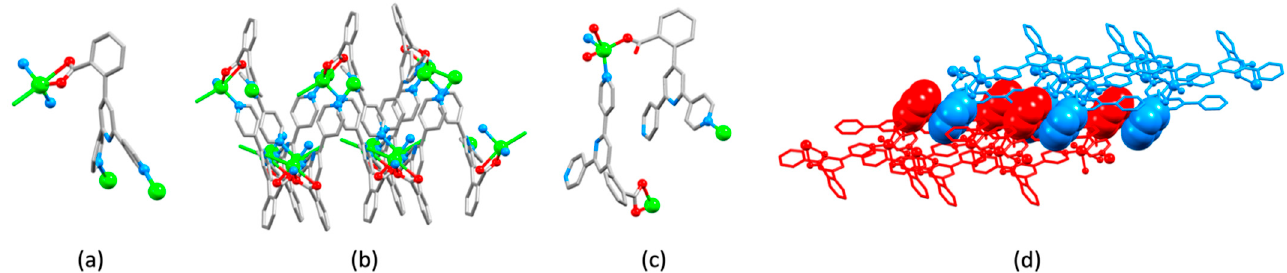
Figure 23. ( a ) The tritopic binding-mode of 34 – in [Zn( 34 )Cl] n (CSD refcode FIZVUH) and ( b ) part of a 2D-sheet in Figure 23. (a) The tritopic binding ‐ mode of 34 – in [Zn( 34 )Cl] n (CSD refcode FIZVUH) and (b) part of a 2D ‐ sheet in [Zn( 34 )Cl] n . ( c ) The two crystallographically independent 34 – linkers in [Zn 2 ( 34 ) 4 ] n · 2 n H 2 O (refcode FIZWAO), and [Zn( 34 )Cl] n . (c) The two crystallographically independent 34 – linkers in [Zn 2 ( 34 ) 4 ] n . 2 n H 2 O (refcode FIZWAO), and (d) π‐ ( d ) π -stacking between phenyl rings in adjacent 2D sheets in [Zn 2 ( 34 ) 4 ] n · 2 n H 2 stacking between phenyl rings in adjacent 2D sheets in [Zn 2 ( 34 ) 4 ] n . 2 n H 2 O.